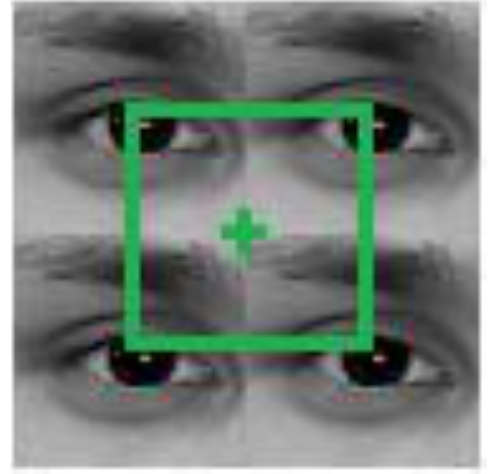
Figure 4. An area possible object center positions (green rectangular) for some primitive position (green